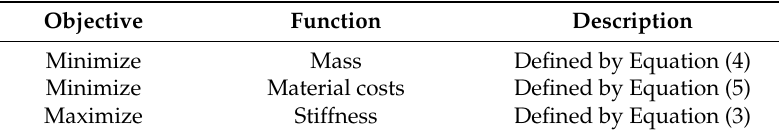
Table 2. Objective functions defined within the size optimization.